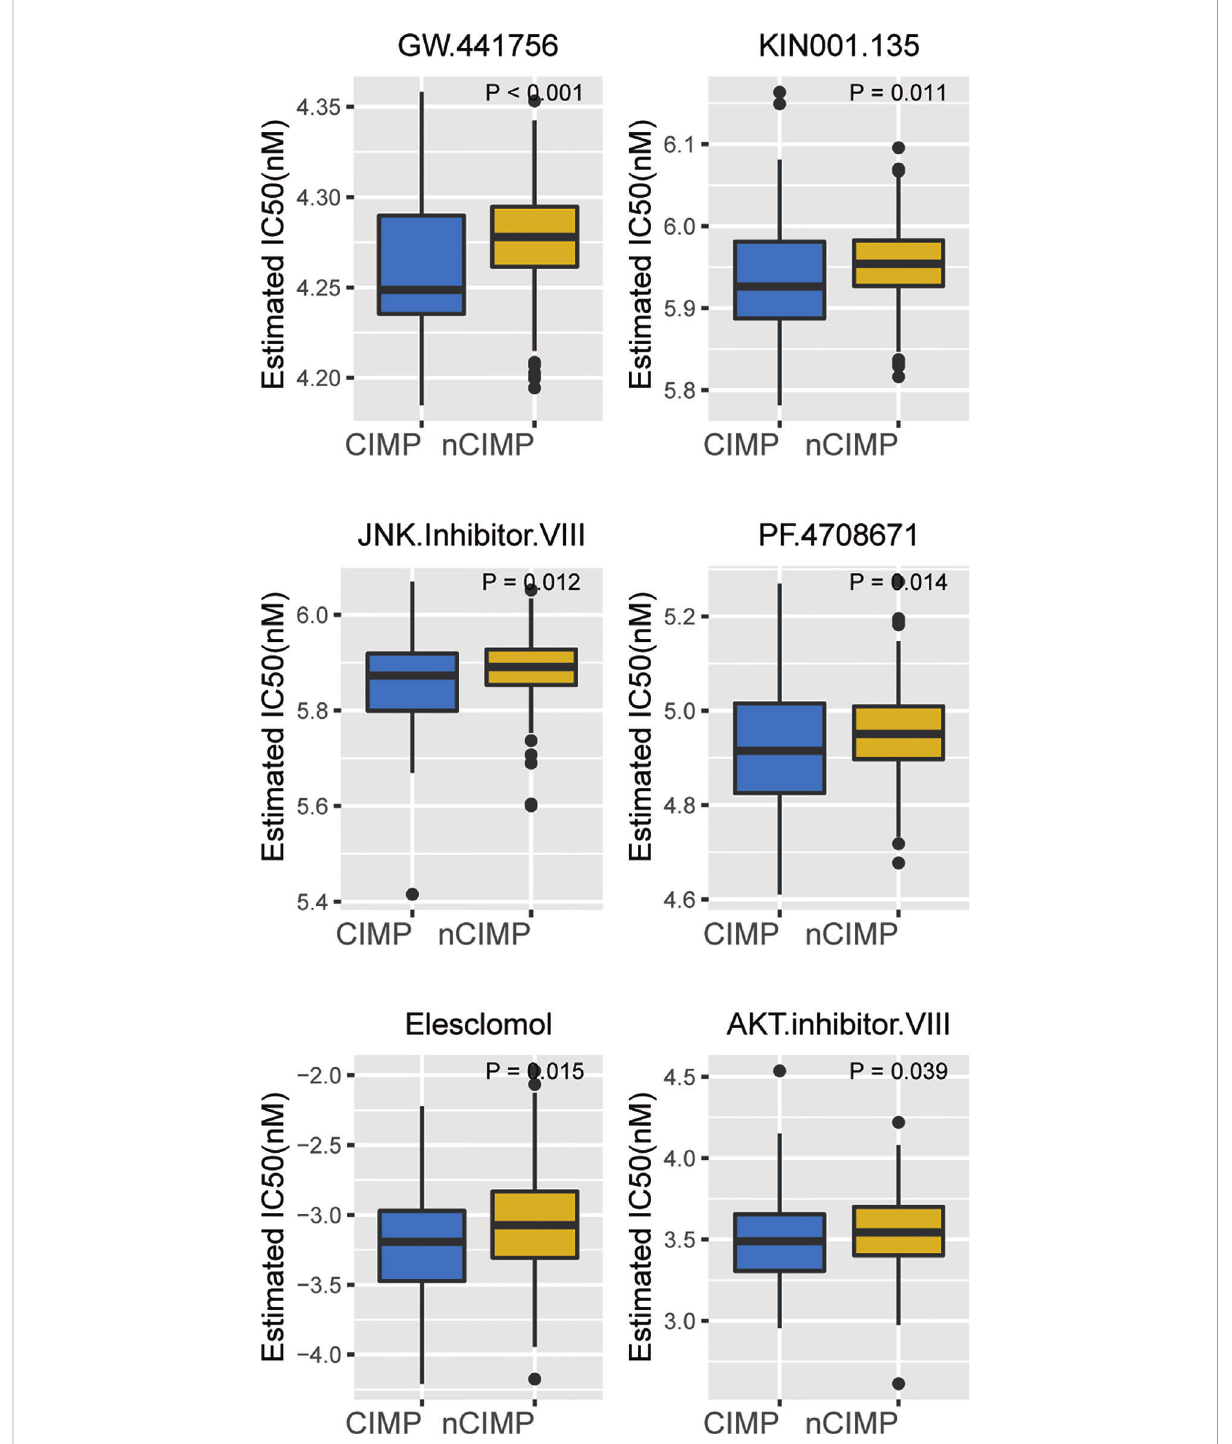
FIGURE 7 Identi fi cation of potential therapeutic drugs for CIMP. Boxplot showing the distribution of estimated IC50 between two epigenetic phenotypes based on GDSC